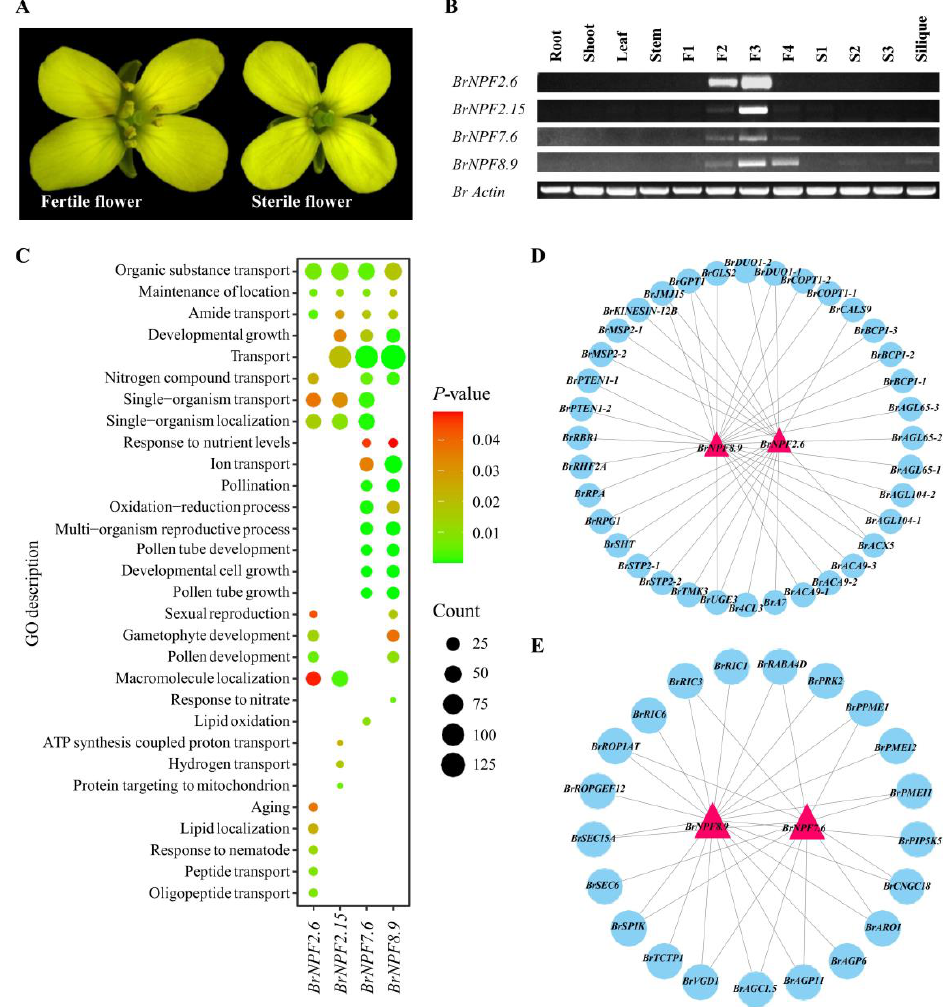
Figure 5. Confirmation and analysis of BrNPFs related to pollen development. ( A ), The phenotype of male Brassica rapa sterile lines. ( B ), Semi-quantitative RT-PCR analysis of BrNPFs related to pollen development within various tissues. ( C ), GO enrichment analysis of co-expression of BrNPFs . ( D ), Network of pollen development-related genes based on co-expression analysis of BrNPF8.9 and BrNPF2.6 . ( E ), Network of pollen tube development-related genes based on co-expression analysis of BrNPF8.9 and BrNPF7.6 .